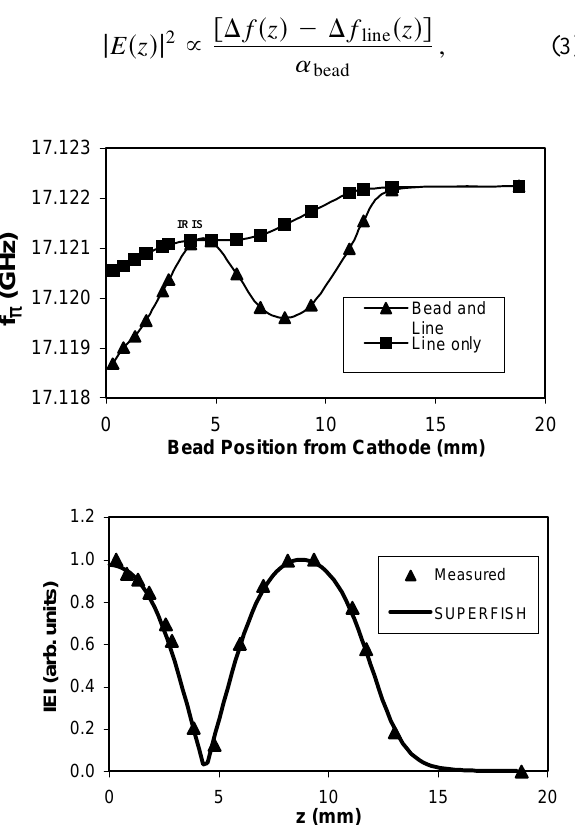
FIG. 3. Measurement of the on-axis field profile of the new RF gun. Top: Frequency perturbation as a function of bead position. Bottom: On-axis field profile derived from both mea- surement and SUPERFISH